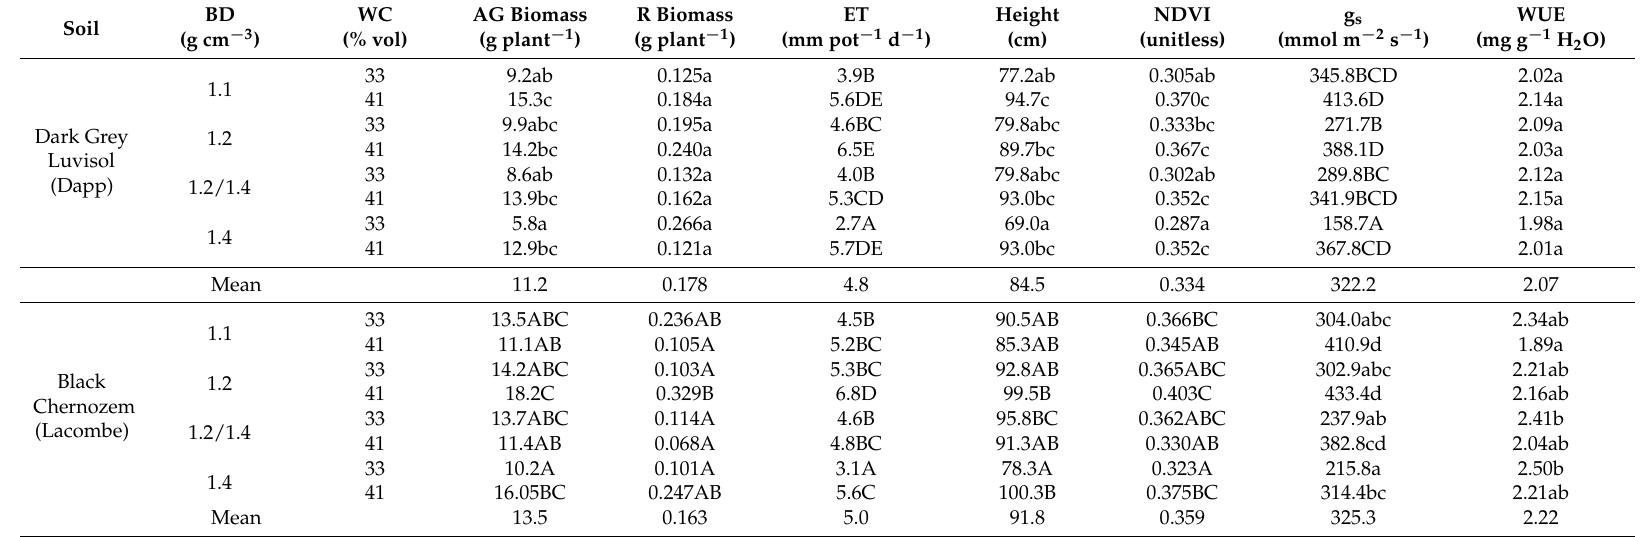
Table 3. Measured parameters during the faba bean cropping phase. The table shows the mean values of each sensor and plant-based measurement, with parameter groupings derived across the eight different treatment combinations of bulk density and volumetric water content for each soil type. Mean values of evapotranspiration (ET), normalized difference vegetation index (NDVI), and stomatal conductance (g s ) are averaged across multiple weeks and multiple experimental units (soil pots) with the use of correlation and variance structures. Mean values for water-use efficiency (WUE), height, and above and below ground dry biomass were averaged across multiple experimental units ( n = 48) at the end of the study. One plant was grown per experimental pot. Treatment combinations are defined in Table 2. BD WC AG Biomass R Soil